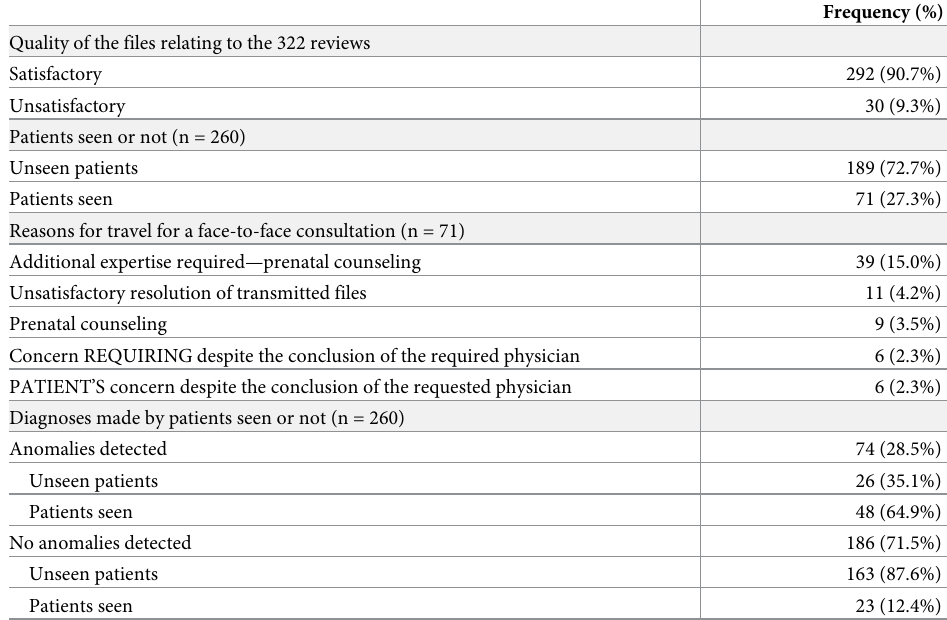
Table 2. Data relating to expertise.